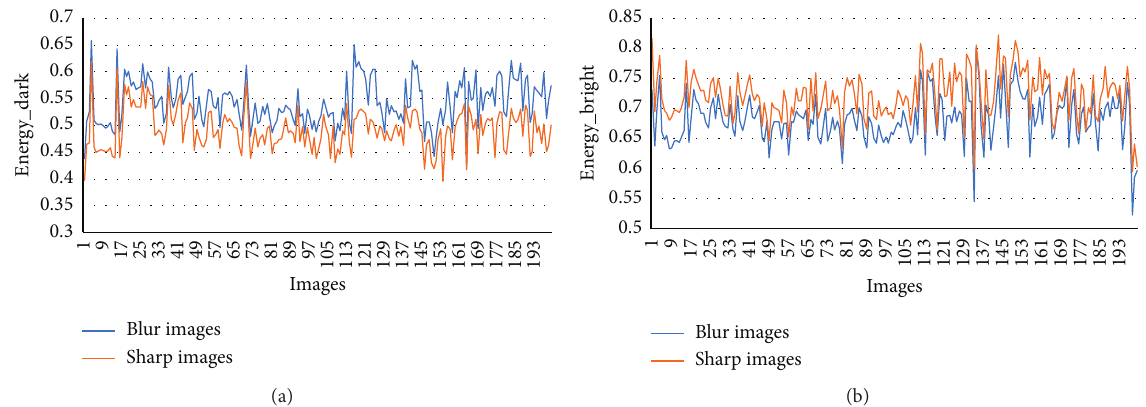
Figure 4: Graph of Energy_dark and Energy_bright on the test image randomly selected from the FLIR dataset: (a) dark energy and (b) bright energy.